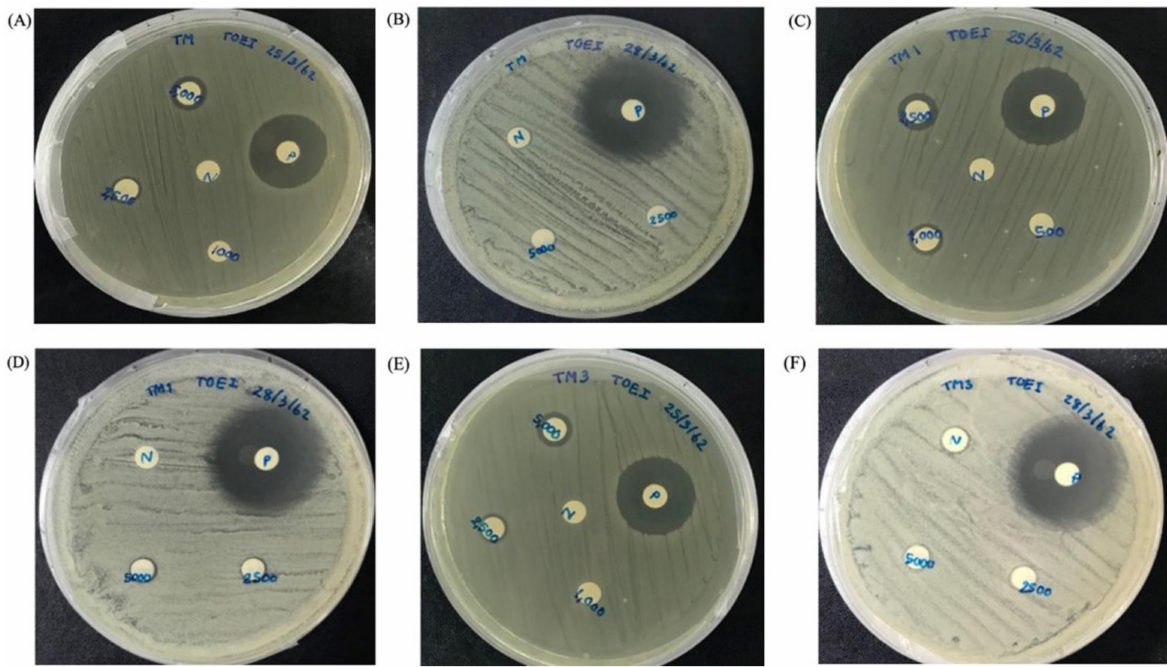
Figure 5. Antibacterial activities assay of E. coli (0157:H7) and S. aureus (ATCC 25923) treated with